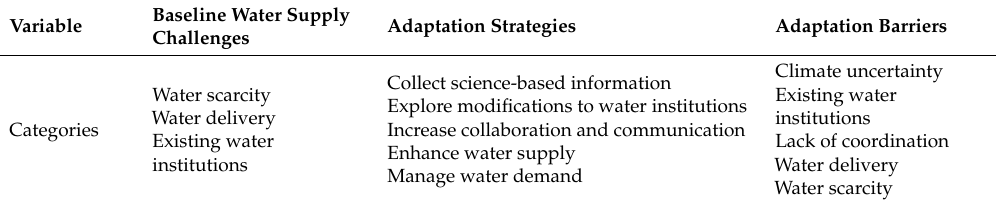
Table A1. Coding categories of identified baseline water supply challenges, adaptation strategies, and adaptation barriers. These categories depict locally identified water supply challenges, adaptation strategies, and adaptation barriers specific to the Truckee-Carson River System case study